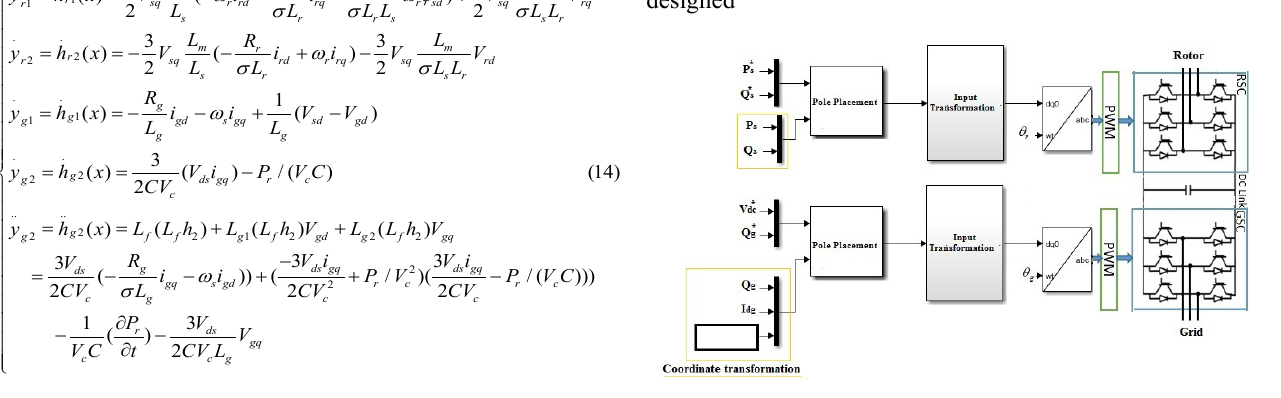
Figure 2. Block Diagram of the proposed ELF approach control